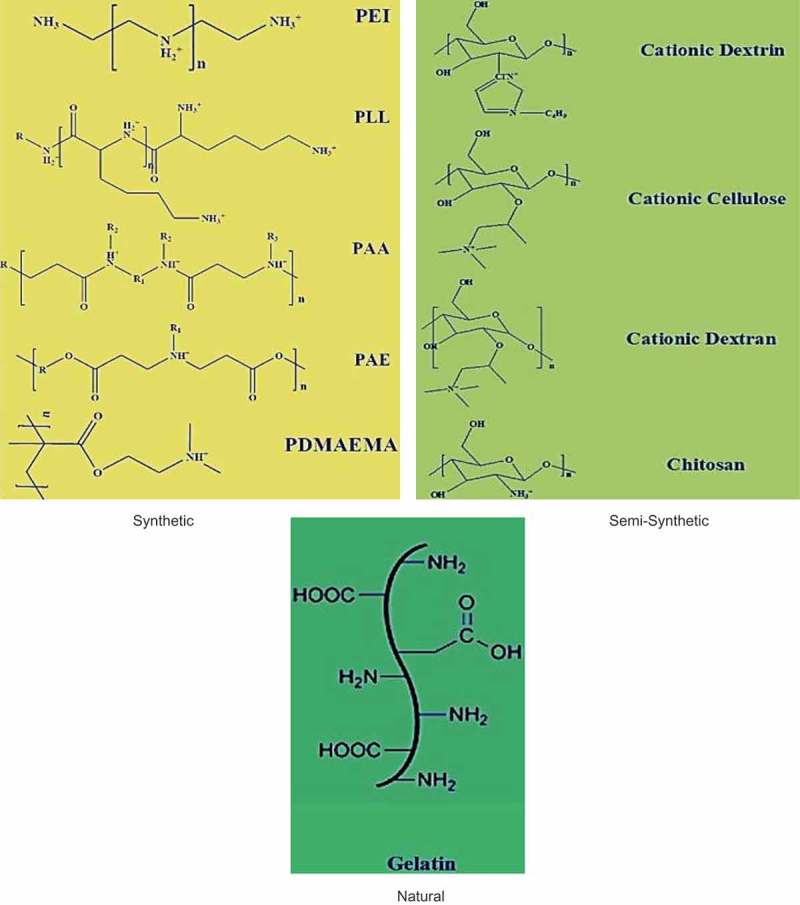
Classification of cationic polymers [14].